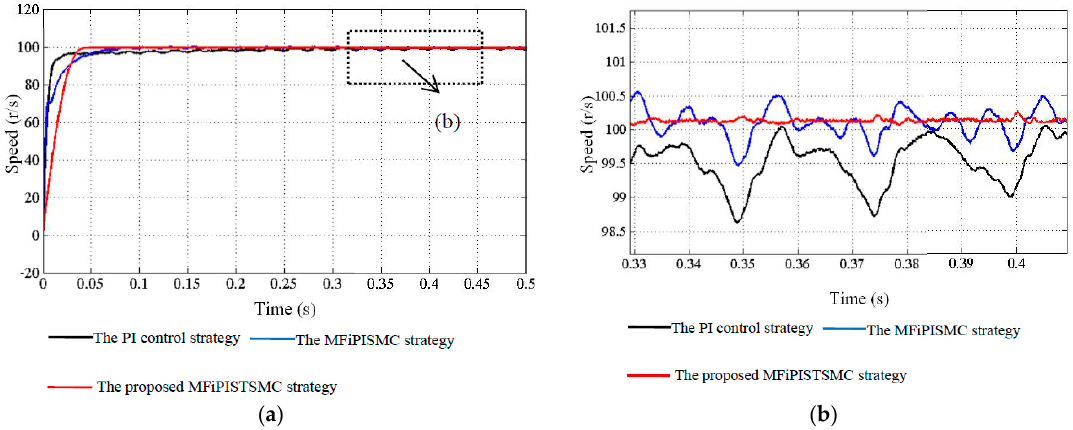
/100 =ω with mN ⋅ 5.0 load starting and stable Figure 4. ( a ) Speed response curves with sr Figure 4. ( a ) Speed response curves with ω r = 100 r / s with 0.5 N · m load starting and stable operation; r ( b ) detailed view of the image ( a ). operation; ( b ) detailed view of the image ( a ). Table 3. The comparative results of the speed response curves with load.